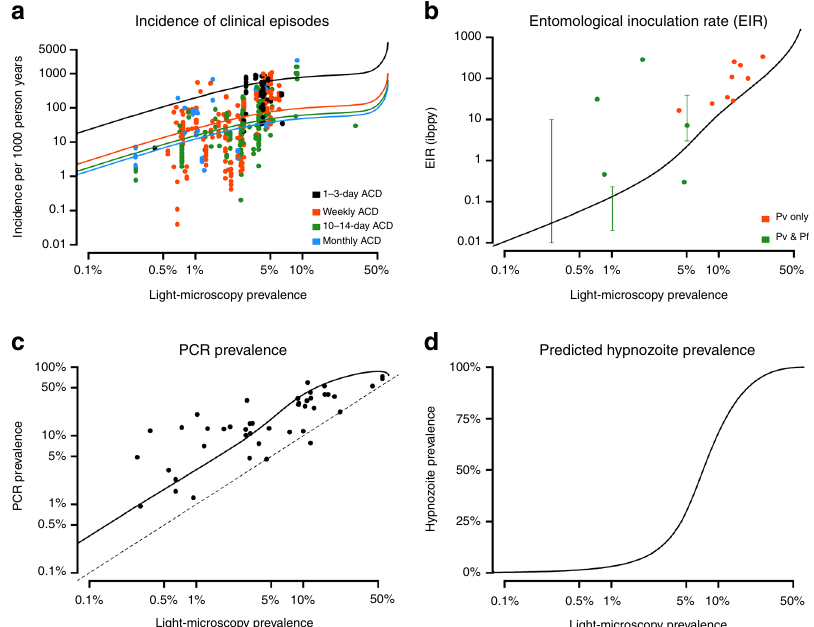
Fig. 2 Validation of model to data from systematic reviews. Data are shown as points and model predictions as solid lines. a Relationship between Pv PR LM and clinical incidence based on data reviewed by Battle et al. 30 . Studies included in this review came from throughout the world, had various age ranges, and differences in the frequency of active case detection (ACD) for clinical cases of P. vivax . b Relationship between EIR and Pv PR LM compared to data reviewed by Battle et al. plus data from a study in Papua New Guinea by Burkot et al. 60 . Orange points denote studies where infectious mosquitoes were con fi rmed as P. vivax positive, and green points denote studies where mosquitoes were identi fi ed as infectious but without Plasmodium species identi fi cation. In some studies, a range was provided instead of a point estimate. c Relationship between Pv PR LM and Pv PR PCR compared to data reviewed by Moreira et al. 31 . Data are from throughout the world and are based on studies with various age ranges. d Model-predicted relationship between Pv PR LM and hypnozoite prevalence. As it is currently not possible to directly detect hypnozoites, this relationship cannot be formally compared to any